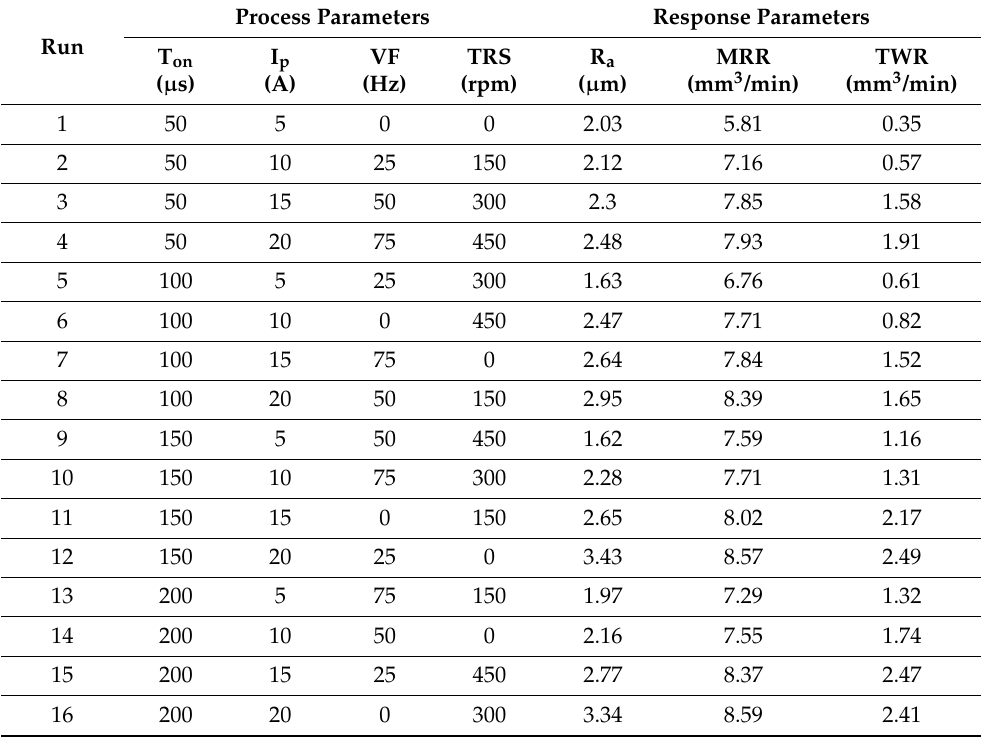
Table 5. Responses measured for each run.